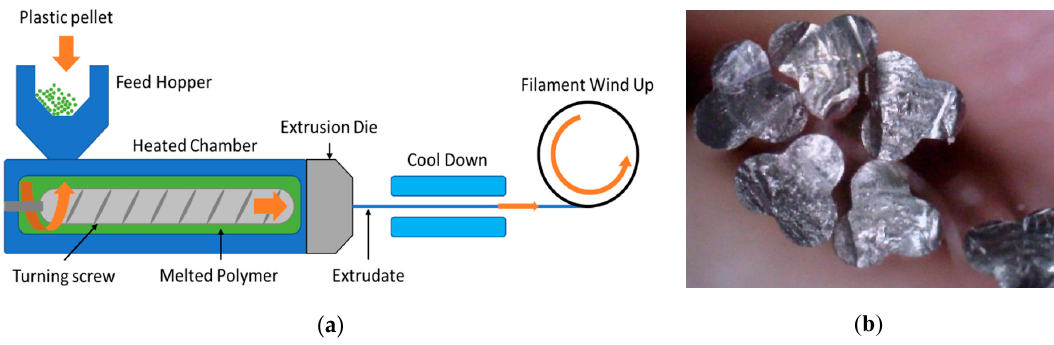
Figure 1. ( a ) Scheme of the extrusion system: screw velocity and velocity of the wind-up machine were optimized to find the best performance in terms of optical losses. In this case, the filaments were air-cooled, since poly (methyl methacrylate) (PMMA) is water absorbent. ( b ) Photo of the cross-sections of the obtained plastic optical fibers.